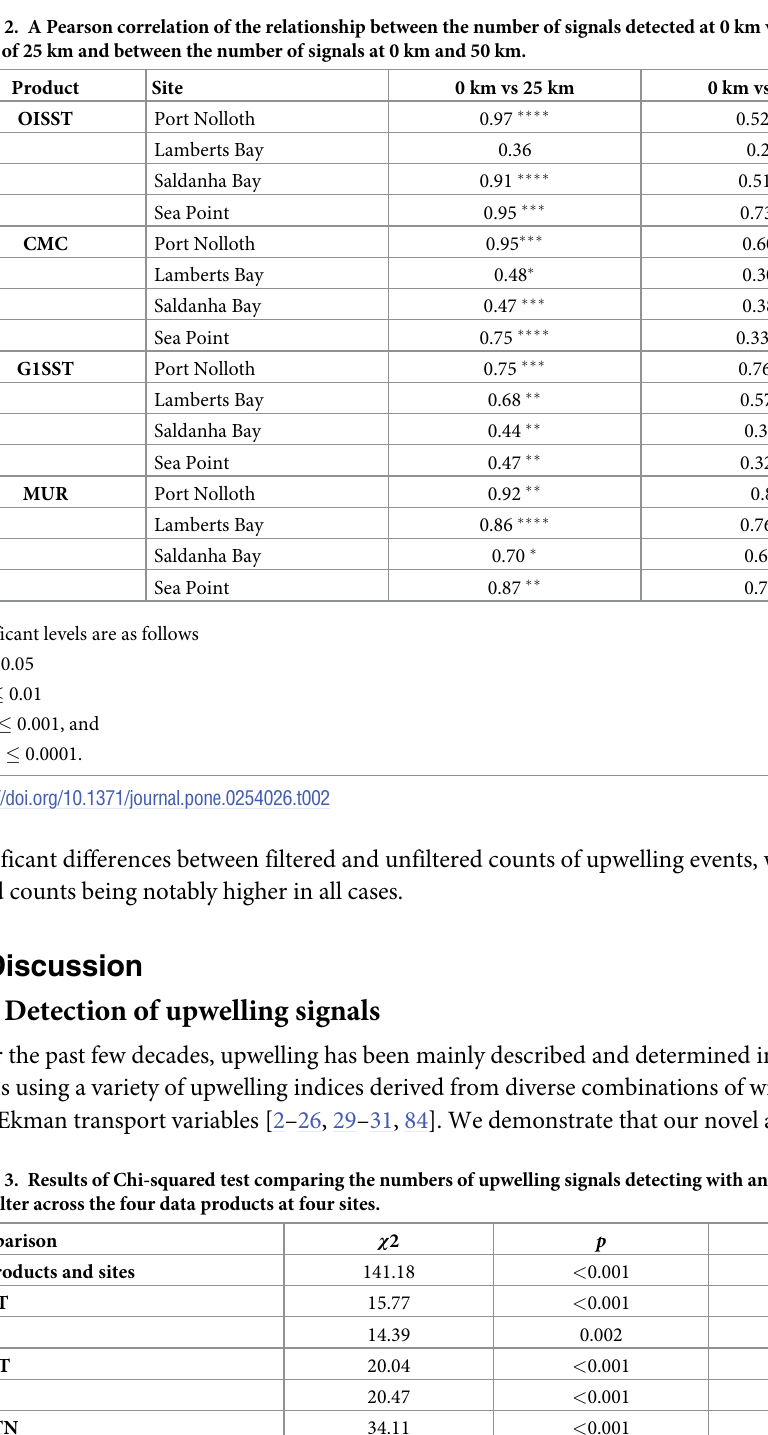
Table 3. Results of Chi-squared test comparing the numbers of upwelling signals detecting with and without SST as a filter across the four data products at four sites. Comparison χ 2 p d.f. All products and sites 141.18 < 0.001 1 OISST 15.77 < 0.001 3 MUR 14.39 0.002 3 G1SST 20.04 < 0.001 3 CMC 20.47 < 0.001 3 SACTN 34.11 < 0.001 3 Lamberts Bay 108.77 < 0.001 4 Port Nolloth 152.45 < 0.001 4 Saldanha Bay 90.41 < 0.001 4 Sea Point 19.65 < 0.001 4